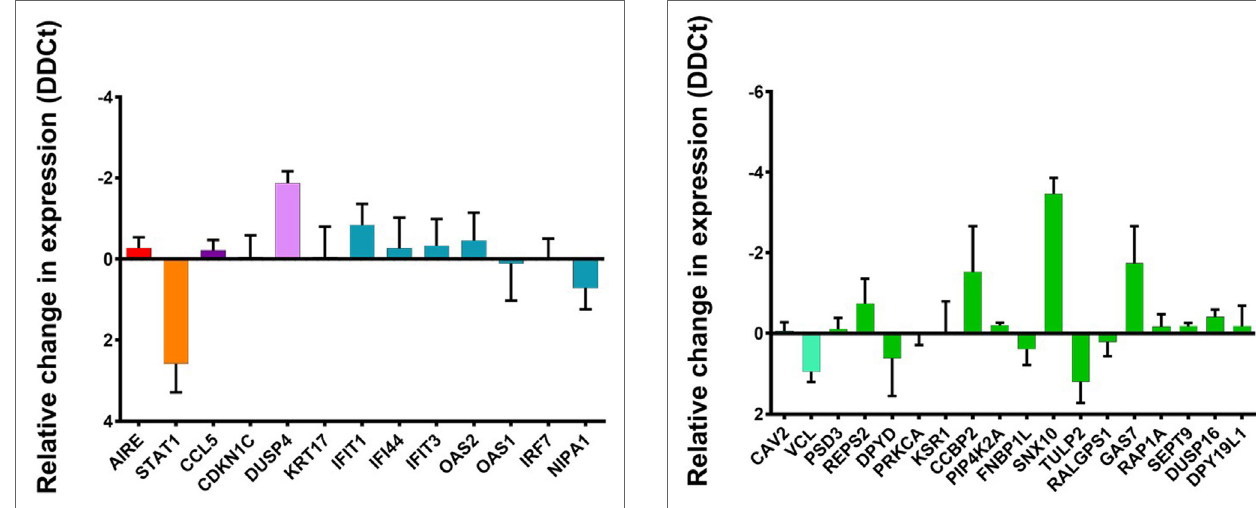
FigUre 6 | Change in relative expression levels of autoimmune regulator (AIRE) downregulated genes, previously reported to be U-STAT1 regulated, but not IFN-regulated. TEC 1A3 AIRE hi cells were treated with either anti-STAT1 or scrambled shRNA, then the expression of 18 genes known to be regulated by AIRE and STAT1 were analyzed including 16 genes conserved ARGs (green barre) (59) and two genes conserved in ARG in TEC1 A3 only (58) (light blue barre). The knockdown of STAT1 revealed significant variation in relative change in expression (DDCt) of CC chemokine- binding protein 2 (CCBP2), growth arrest-specific protein 7 (GAS7), and sorting nexin 10 (SNX10), slightly variation (REPS2, VCL, DPYD, TULP2) or unchanged (CAV2, PSD3, PRKCA, KSR1, PIP4K2A, FNBP1L, RALGPS1, RAP1A, SETT9, DUSP6, and DPY19L1). DDCt values are averaged from three